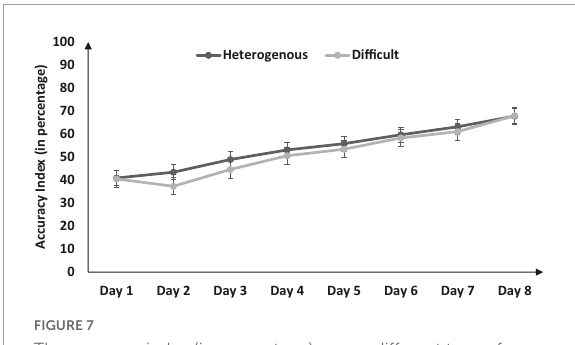
FIGURE7 The accuracy index (in percentage) across different type of training conditions and baseline/training days (Day 1 to Day 8). The error bars show 95% CI around point estimates.